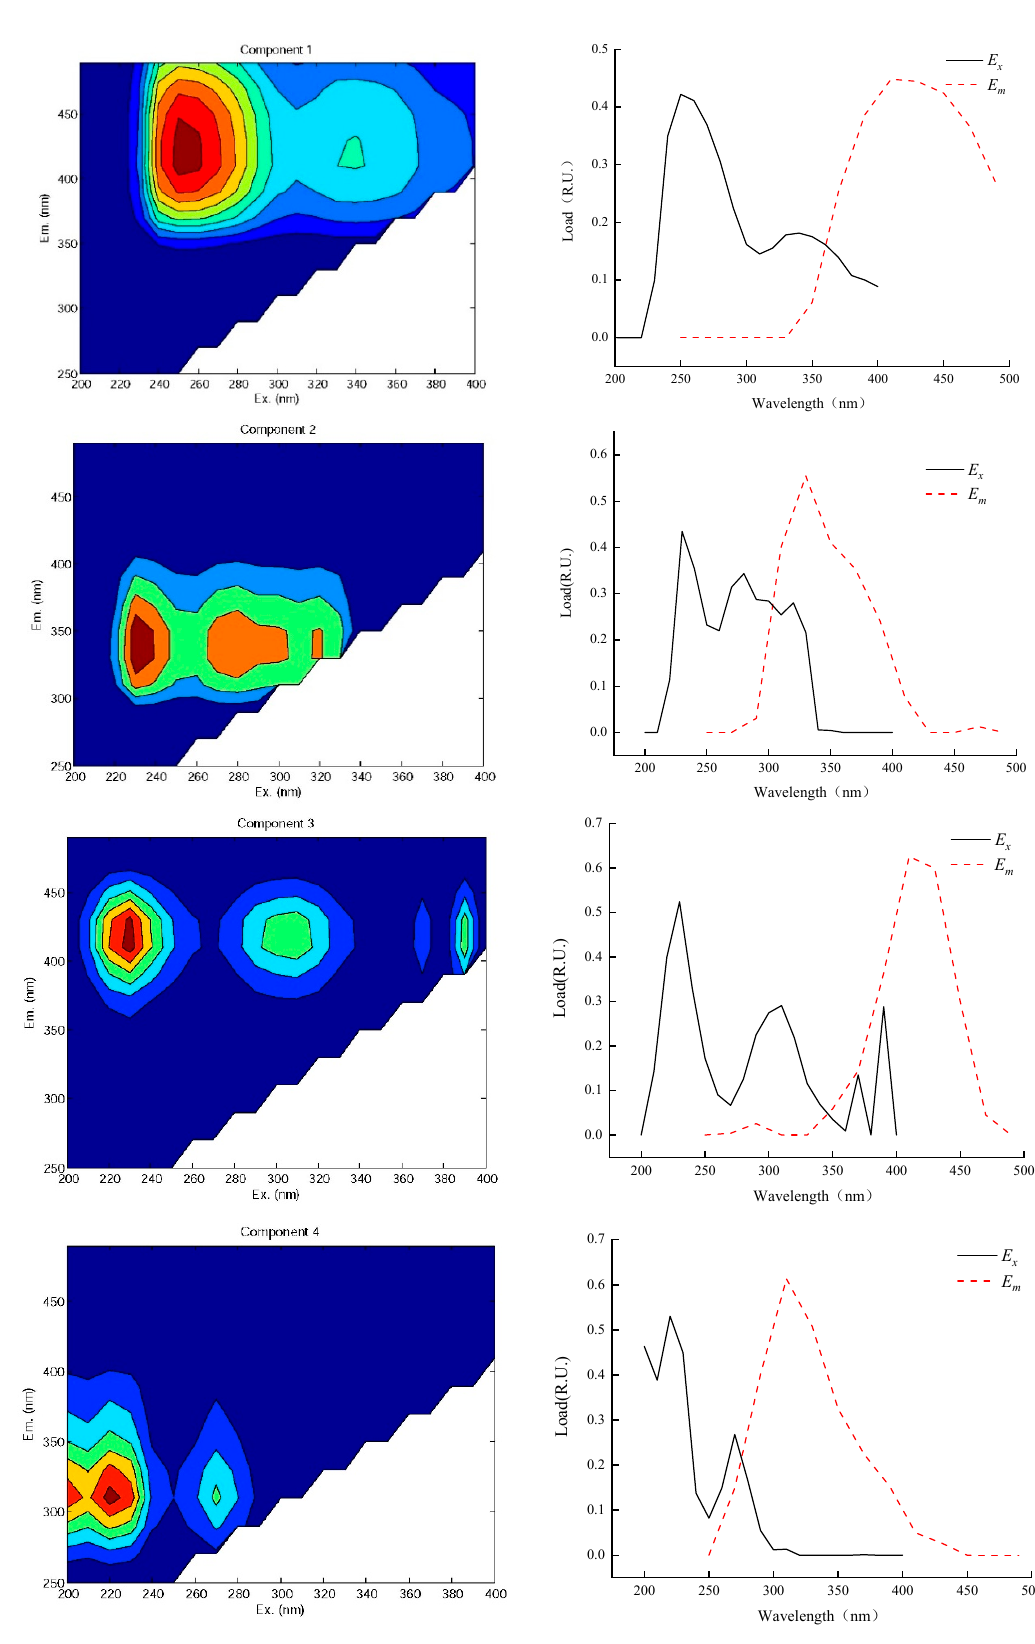
Figure 5. Schematic diagram of mine water effluent composition based on parallel factor. Four components were identified in the effluent samples of all the mine water treat- ment stations by the parallel factor method (Figure 5). C1 (Ex/Em: 260 nm/410 nm) was